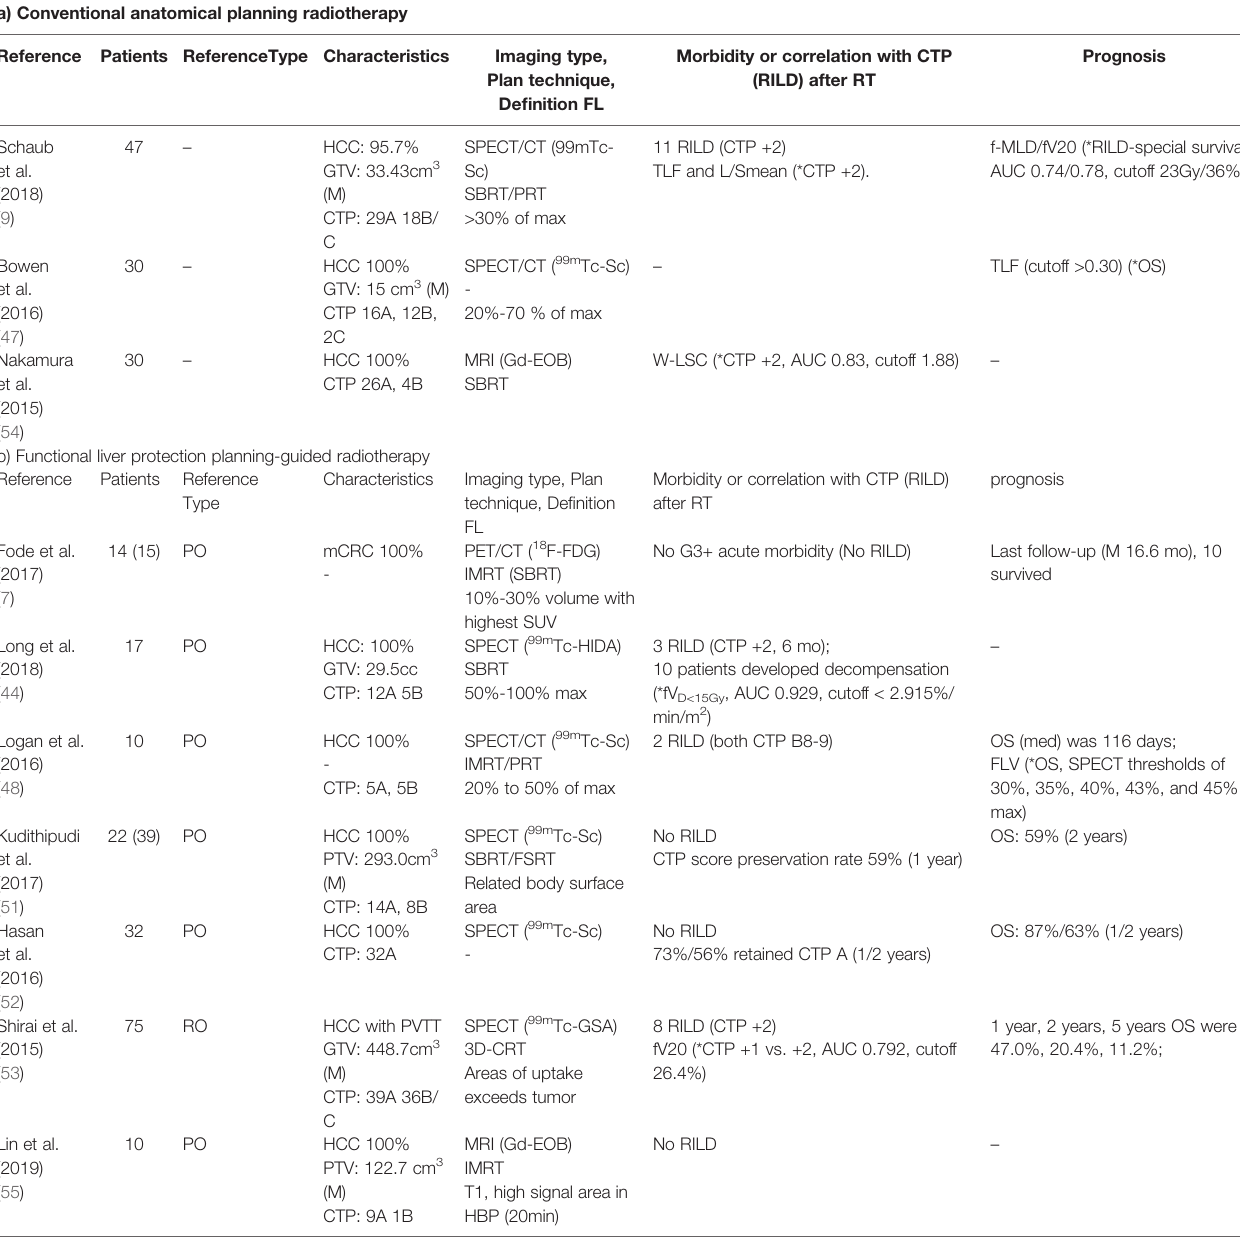
TABLE 2 | Description of functional liver imaging correlating with clinical liver function, radiation-induced liver disease and